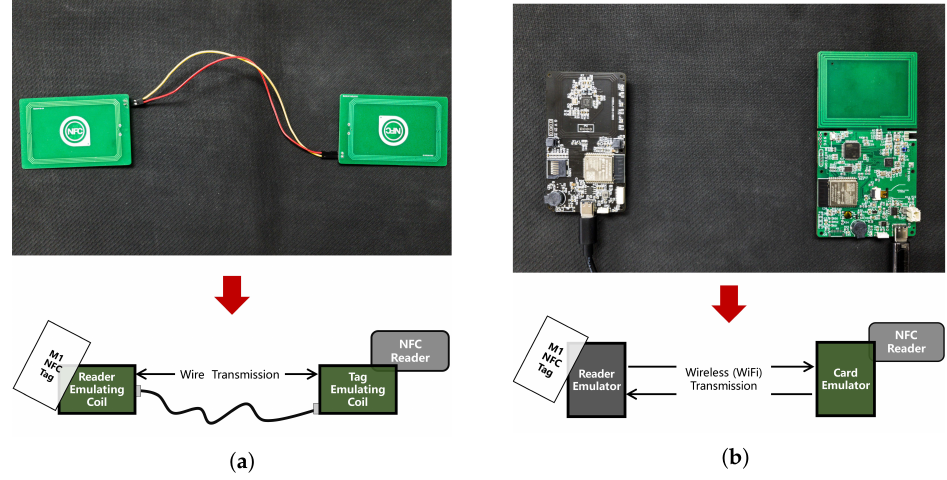
Figure 3. Hardware devices for the relay attacks. ( a ) Implementation of the hardware device for wired relay attacks. ( b ) Implementation of the hardware device for relay-over-WiFi attacks.